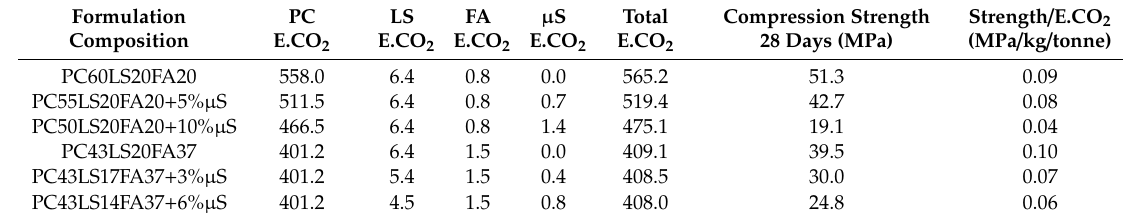
Table 8. Embodied CO 2 (kg / tonne) associated with strength of quaternary cementitious matrices.